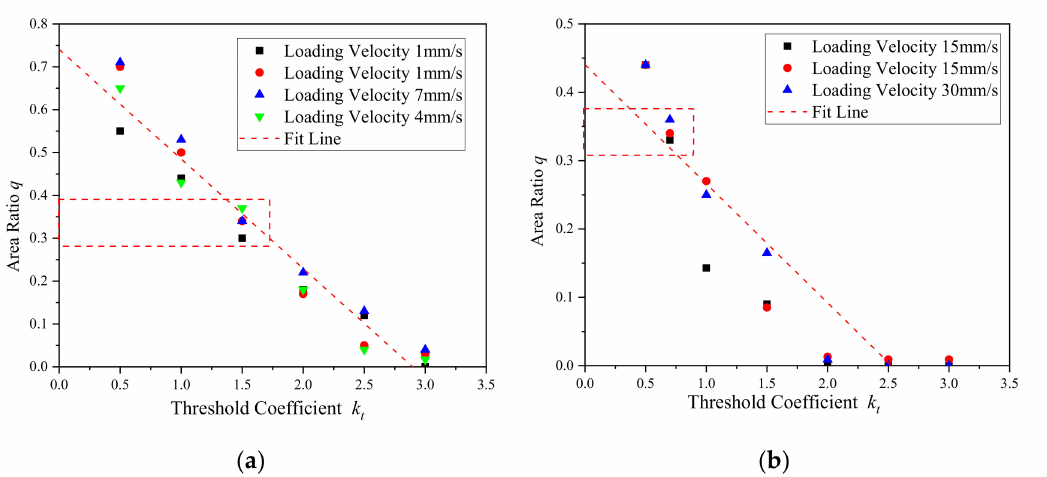
Figure 7. Area ratio coefficient q versus threshold coefficient k t . ( a ) V load of 1 mm/s, 4 mm/s and 7 mm/s; ( b ) V load of 15 mm/s and 30